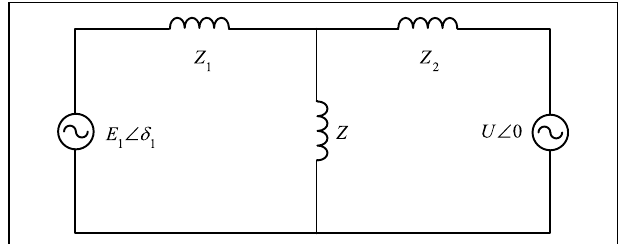
FIGURE 6 | Equivalent circuit of active support VSC.